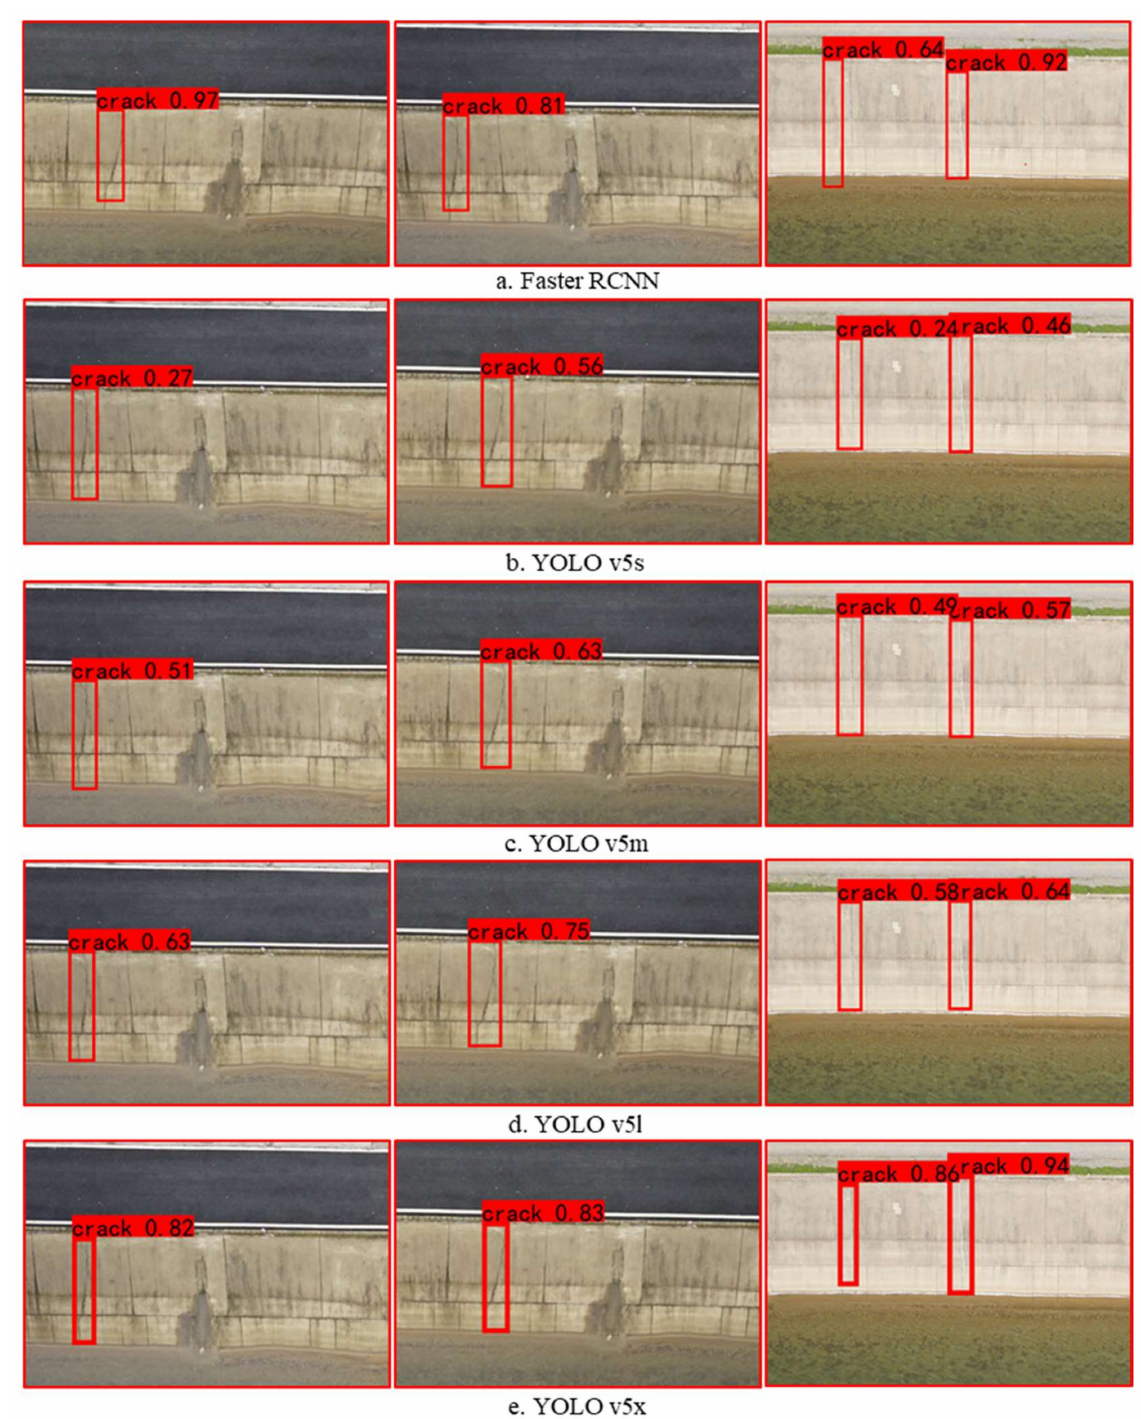
Figure 12. Testing results of each